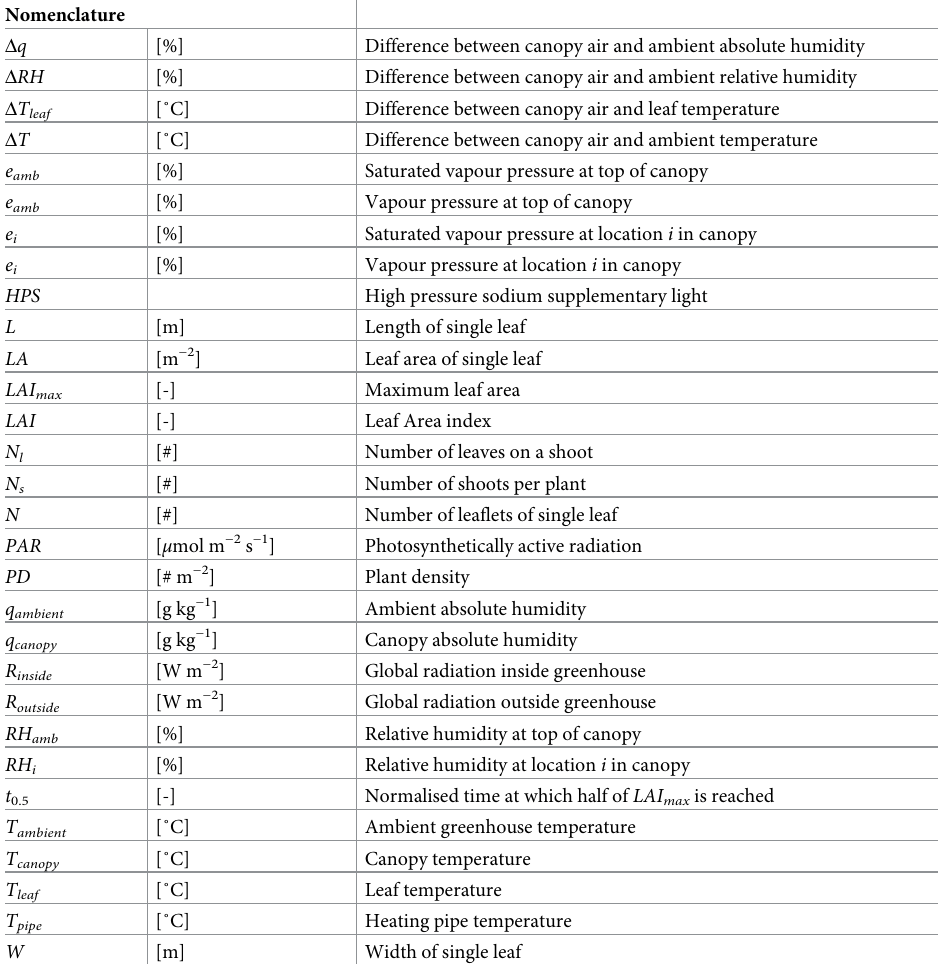
Table 1. List of definition of all the used